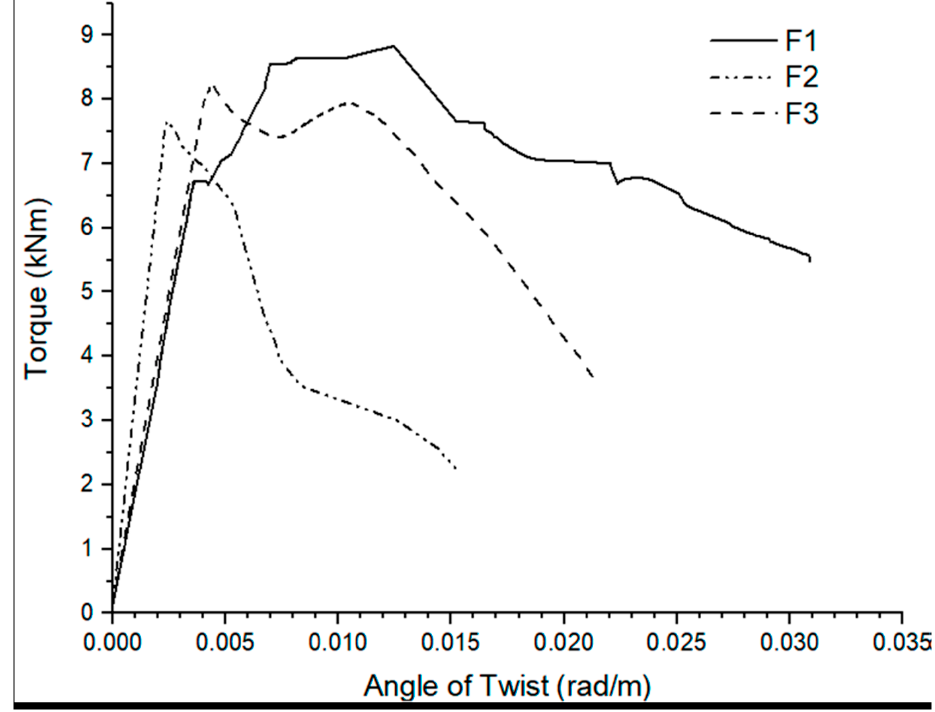
Figure 4. Torque vs. angle of twist for beam samples formed only with fibre reinforcement [39].